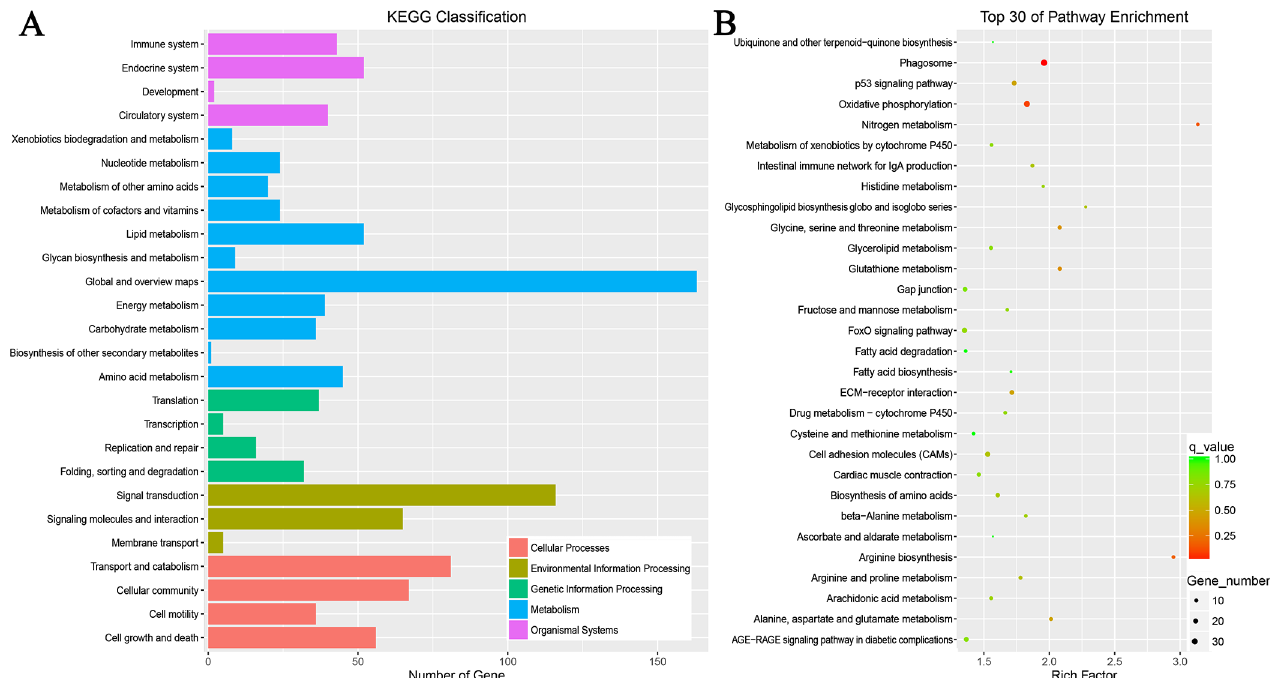
Fig 6. KEGG pathway analysesof differentially expressedgenes in Gushi chickens and AA chickens. A shows the KEGG pathway classification, and B shows the 30 most significantly enrichedKEGG